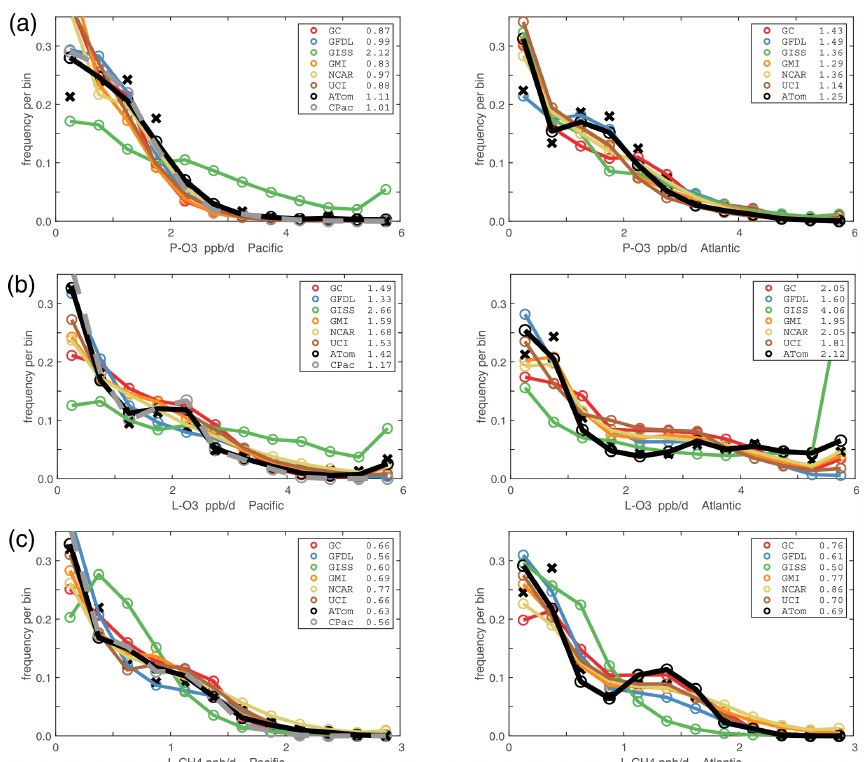
Figure 5. Probability densities (PDs, frequency of occurrence) for the ATom-1 three reactivities (rows: P-O3, L-O3, and L-CH4 in ppbd − 1 ) and for the Pacific and Atlantic from 53 ◦ S to 60 ◦ N (columns left and right). Each air parcel is weighted as described in the text for equal frequency in large latitude–pressure bins and also by cosine (latitude). The ATom statistics are from the UCIZ model, using MDS-2b and revised RDS* protocol (HNO 4 and PAN damping). The Pacific results (solid black) also show the central Pacific alone (dashed gray). The six models’ values for a day in mid-August are averaged over longitude for the domains shown in Fig. S1 and then cosine (latitude)-weighted. Mean values (ppbd − 1 ) are shown in the legend. The PD derived from the ATom 10s parcels binned into 1 ◦ latitude by 200m altitude (as shown for the tropics in Fig. 2) is typical of a high-resolution global model and denoted by black Xs.